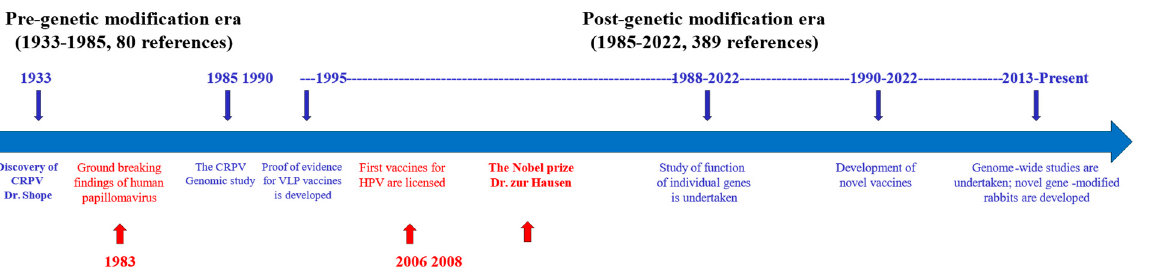
Figure 1. Several milestones of the CRPV rabbit model (blue) and HPV study (red). The rabbit model has played a pivotal role in HPV vaccine development and better understanding of HPV pathogenesis. The research using the rabbit model can be divided into two periods based on the first report on the genomic sequence of CRPV: pre- genetic modification era and post-genetic modification era. The notable research activities on the rabbit model have continued to reduce over the last two decades.